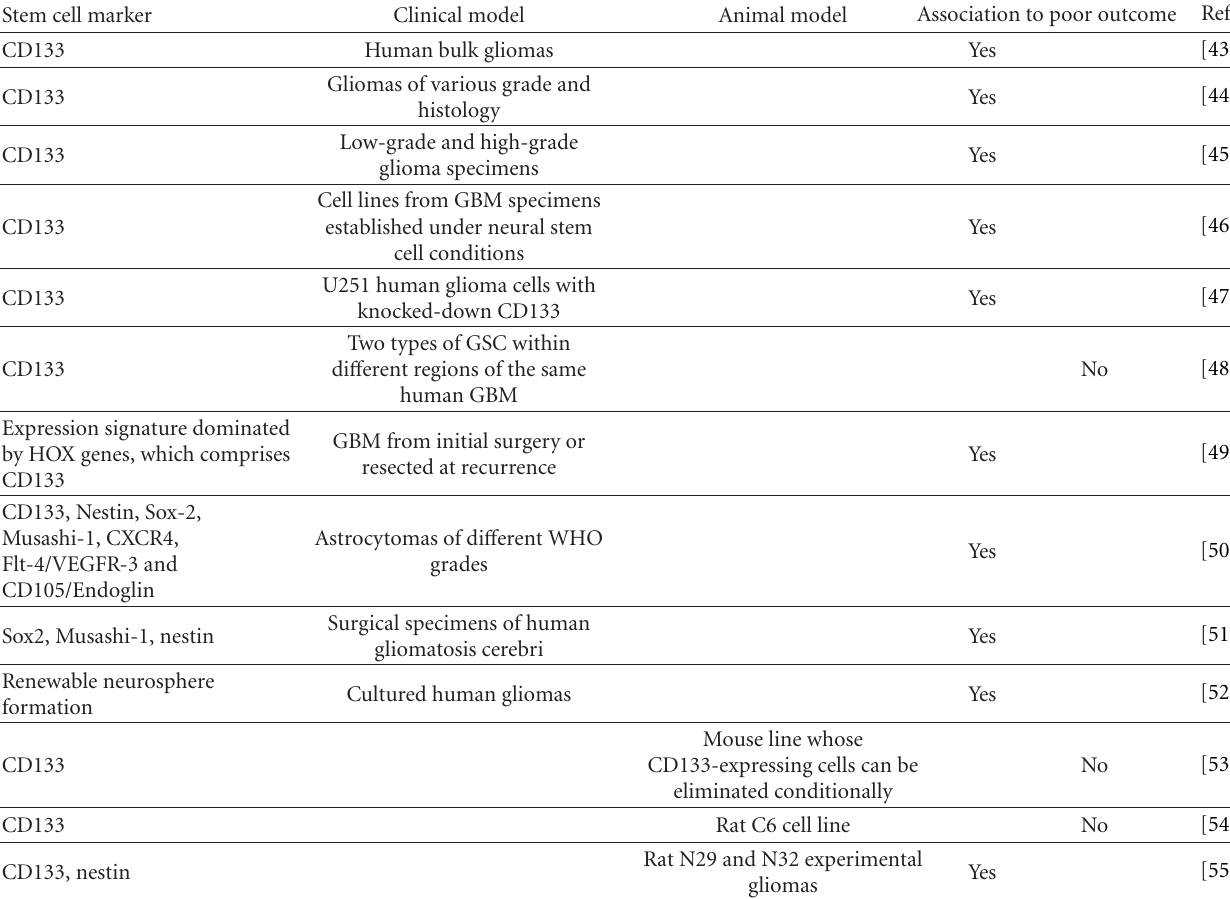
Table 2: Stem cell involvement in high grade glioma patient’s